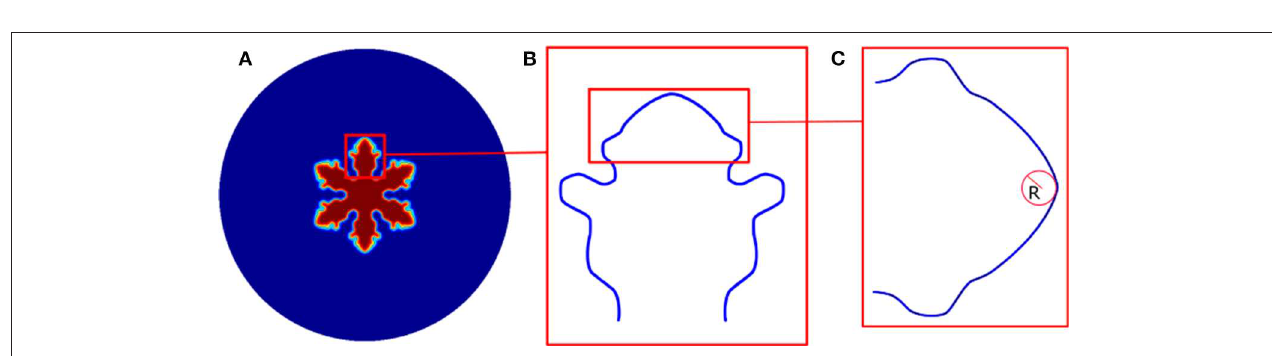
0.1). (B) Interface contour. (C) Approximated tip radius R . =